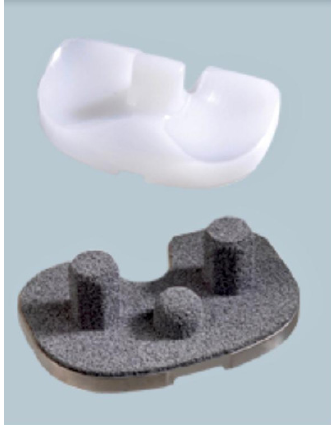
Figure 1. Three-peg modular TMT tibial component.